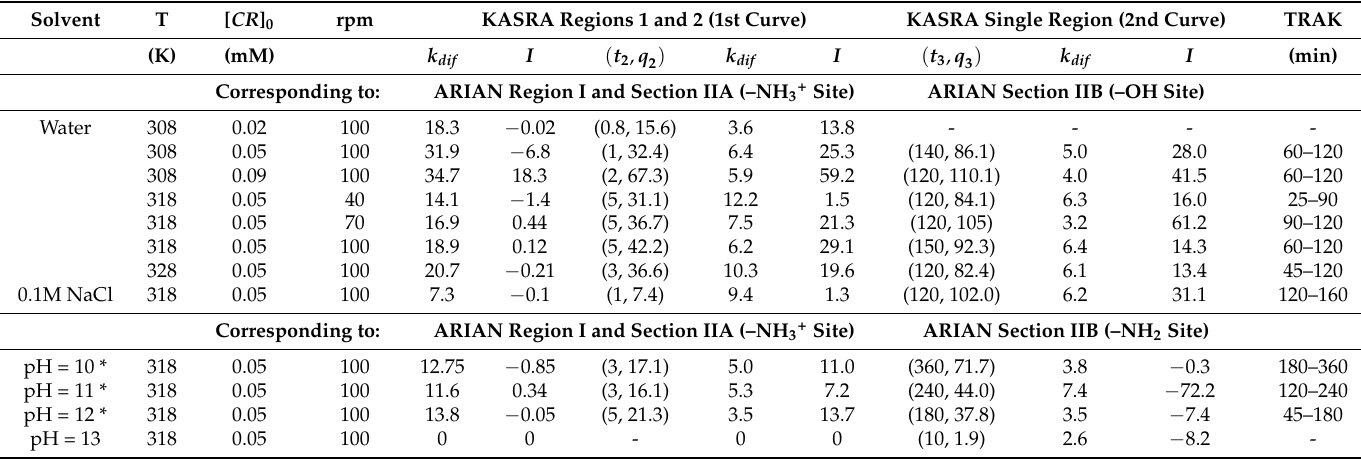
Table 7. Coefficients of the pore-diffusion equation for kinetics of CR adsorption on GO/PAMAM nanocomposite at different temperatures and in various shaking rates and initial CR